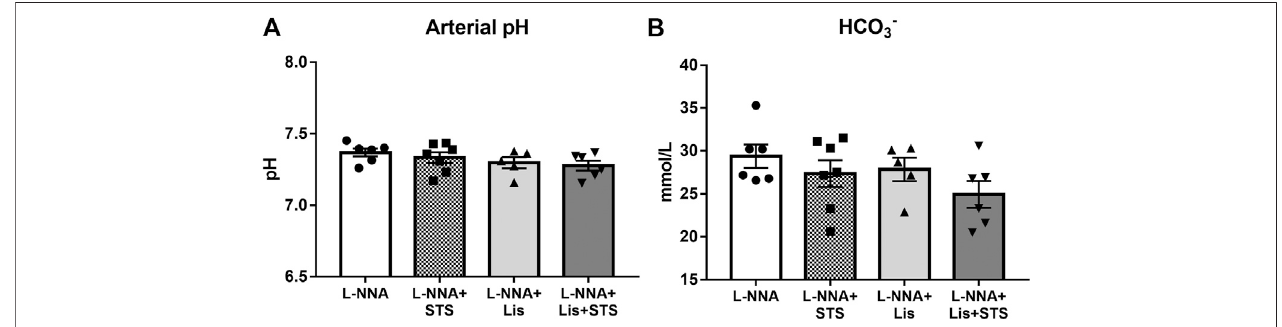
FIGURE 5 | Oral treatment of STS does not lead to metabolic acidosis. (A) pH and (B) HCO 3 − were measured in arterial blood via blood gas analysis at the end of the experimental protocol. N (cid:2) 5 – 7.